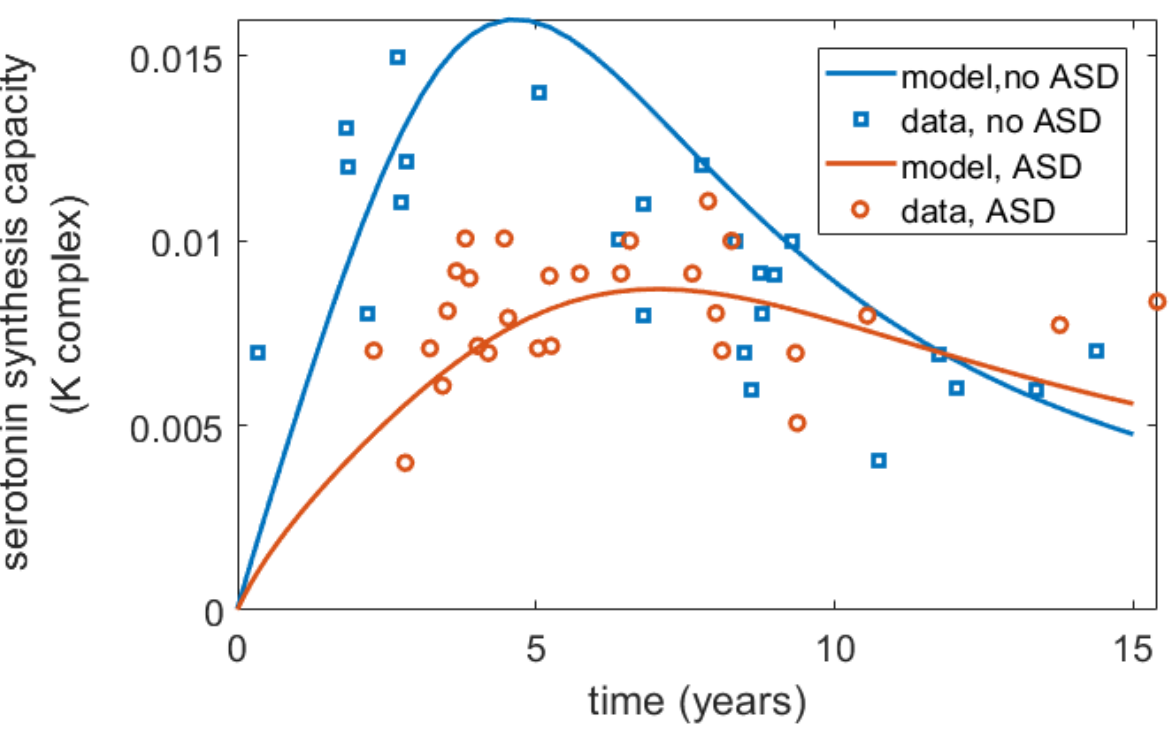
Figure 3. Differences in serotonin synthesis capacity (K complex, mL/g/min) over time for ASD and non-ASD children as reported by Chugani et al. [17] and captured by the model. The published data from [17] were digitized using WebPlotDigitizer.